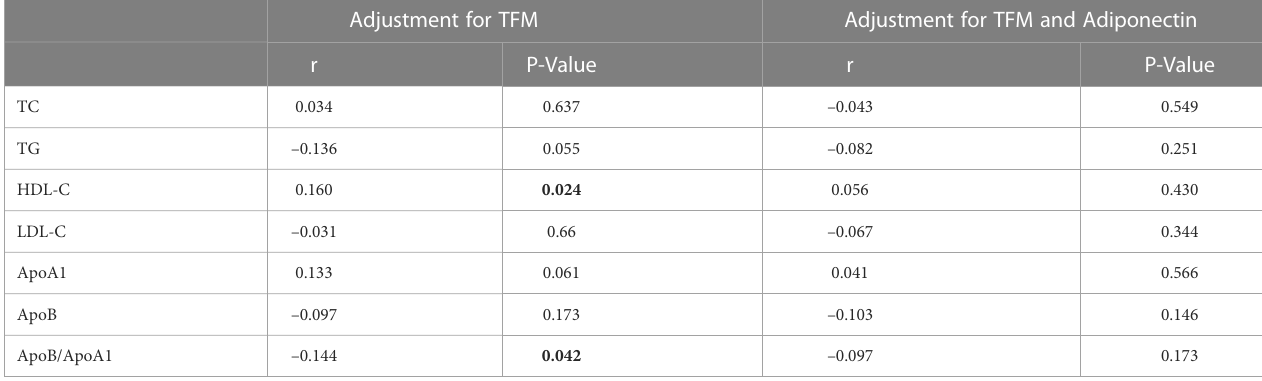
TABLE 3 Partial correlations between LFM and serum lipids in the whole cohort. Adjustment for TFM Adjustment for TFM and Adiponectin